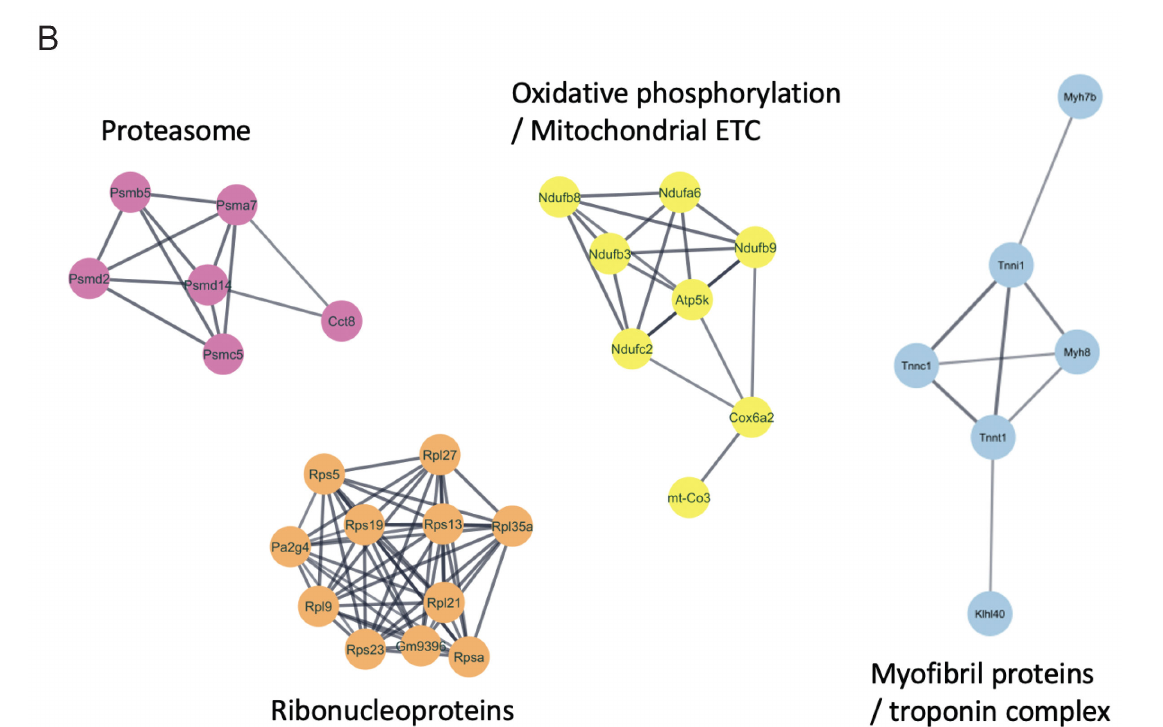
Figure 3. Ingenuity pathway analysis (IPA) and functional enrichment of protein–protein interaction networks. ( A ) Canonical pathway enrichment analysis generated using Qiagen IPA software based on all differentially expressed proteins. ( B ) STRING networks based on all differentially expressed proteins show enrichment in particular GO-terms and KEGG pathways, including proteasomal proteins, proteins involved in OXPHOS and the mitochondrial electron transport chain (ETC), as well as ribonucleoproteins and myofibril/troponin complex